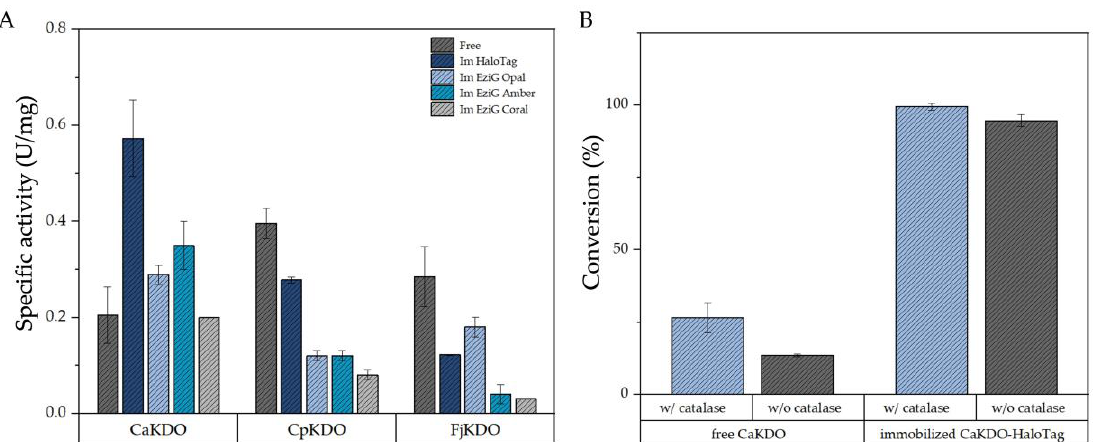
Figure 2. ( A ) Specific activities for L-lysine hydroxylation catalyzed by immobilized KDOs and the respective purified (free) variants with His-Tag. Assays were performed in 1 mL with 200 mM HEPES, pH 7.5, with 0.5 mg mL − 1 immobilized or free enzyme, 100 mM L-lysine, 150 mM α -KG, 2.5 mM L-ascorbic acid, 0.01 mM DTT, and 1 mM (NH 4 ) 2 Fe(SO 4 ) 2 for 1 h at 25 ◦ C in an overhead shaker. ( B ) Conversion of free Ca KDO (with His-Tag) and HaloTag®-immobilized Ca KDO with and without 1 mg mL − 1 catalase after a 24 h reaction time. Assays were performed in 1 mL with the same mixture (see A) on a thermo shaker for 24 h at 21 ◦ C, 750 rpm. Error bars are the result of two technical replicates or, in case of the immobilized variants, of two independent immobilizations.